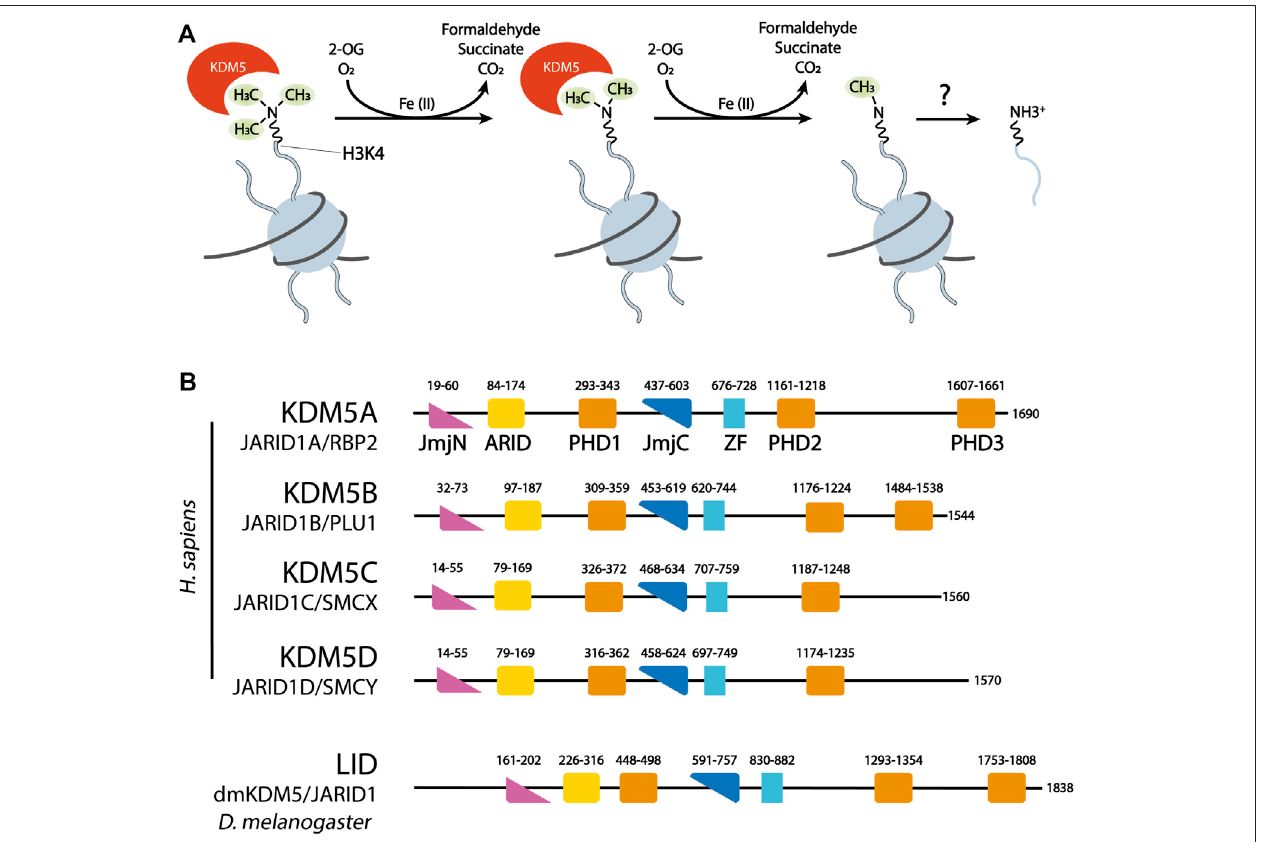
FIGURE 1 | (A) KDM5 demethylases remove methyl groups from H3K4 in a sequential manner, using the dioxygenase activity of their catalytic JmjC domain. 2- Oxoglutarate (2-OG) is decarboxylated to succinate. Formaldehyde, one of the products of demethylation, is commonly detected in quantitative assays of JmjC demethylase activity. (B) Domain organization of the four human KDM5 demethylases and the Drosophila KDM5 homolog Lid. ZF = C5HC2 Zinc Finger. Numbers correspond to the amino acid numbering of each KDM5 protein.